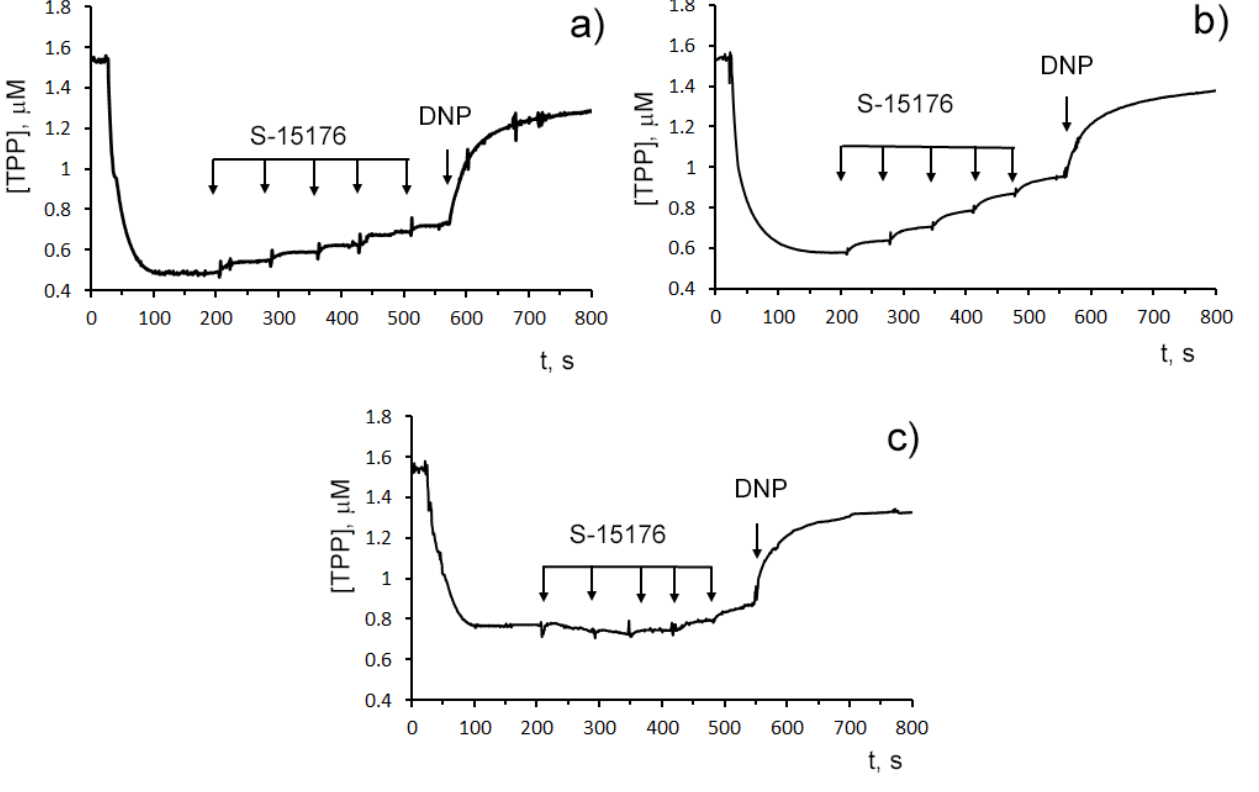
Figure 2. Sequential addition of 10 µ M S-15176 gradually decreases the membrane potential of isolated rat liver mitochondria energized by the complex I substrates (2.5 mM potassium glutamate + 2.5 mM malate) ( a ), or the complex II substrate (5 mM potassium succinate in the presence of 1 µ M rotenone) ( b ), but not by the complex IV substrates (5 mM ascorbic acid + 0.2 mM TMPD) ( c ). Mitochondrial membrane potential was estimated by the distribution of tetraphenylphosphonium bromide (TPP + ) with an ion-sensitive electrode. Additions: 10 µ M S-15176 (five pulse additions), 50 µ M DNP. Typical traces are shown ( n = 6).